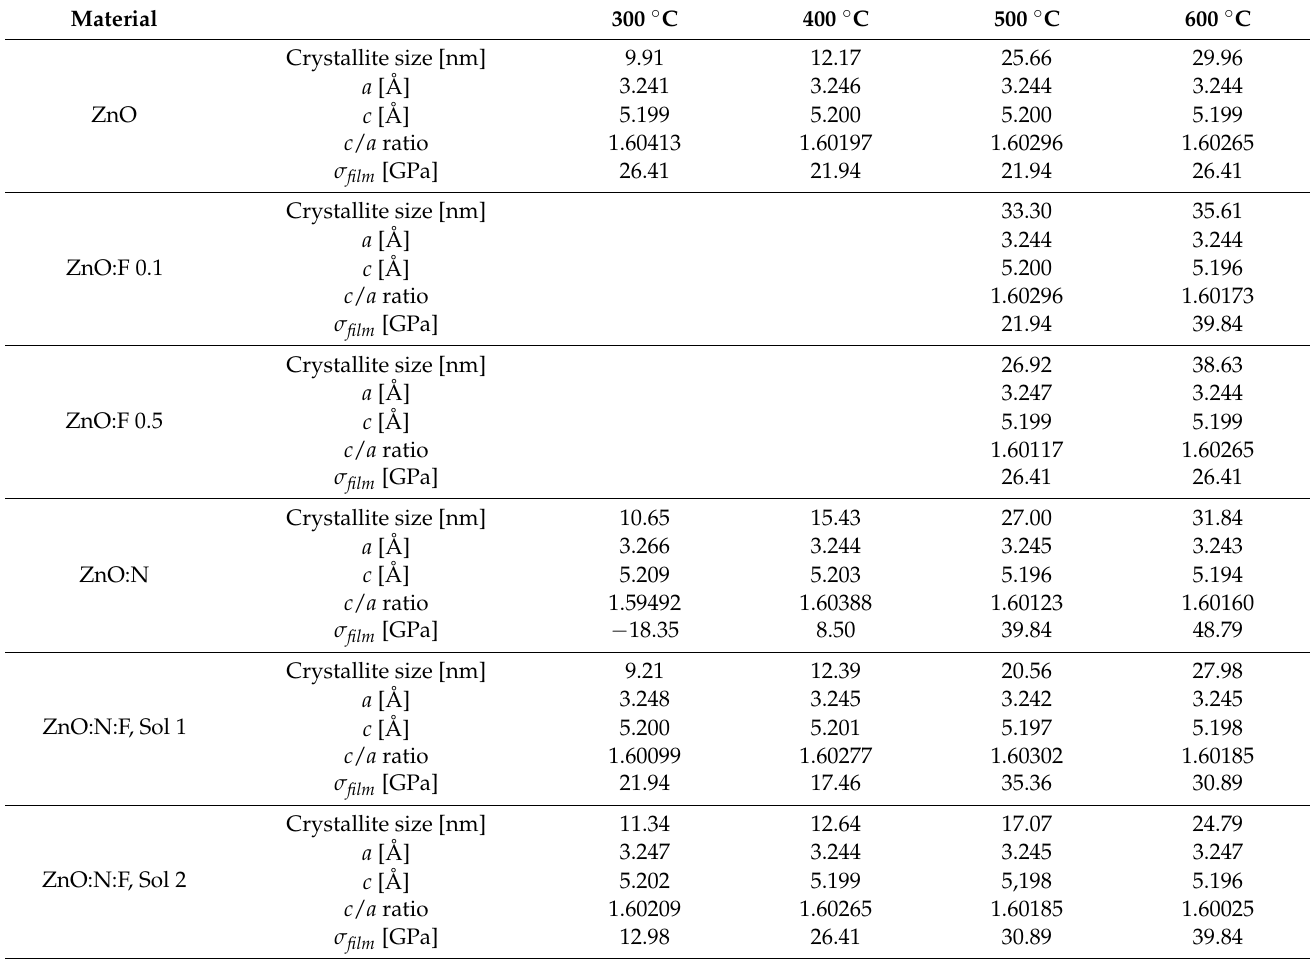
Table 1. Crystallite sizes, lattice parameters, c and a , c / a ratio and residual stress σ film are determined from XRD patterns of ZnO based